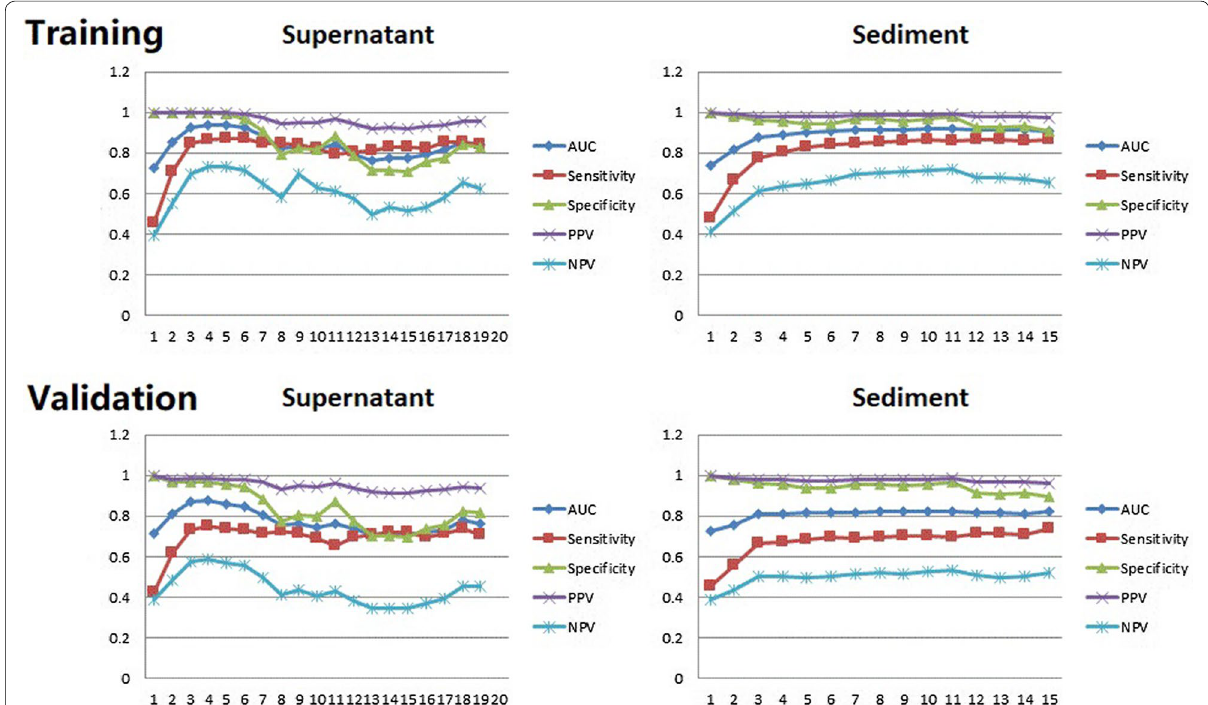
Fig. 5 Averaged diagnostic parameters of the logistic models for the genetic diagnosis of bladder cancer. For urine supernatant, all parameters of the models are satisfactory when gene combinations having three, four, and five genes ( TERT , FGFR3 , TP53 , PIK3CA, and KRAS ) were used. In contrast, the models using urine sediments require the combination of seven ( TERT , FGFR3 , TP53 , HRAS , PIK3CA , KRAS, and ERBB2 ) or more genes to attain satisfactory predictive potential. The X-axis represents the number of genes factored into the model. The Y-axis plots diagnostic potential, with 1.0 representing perfect disease